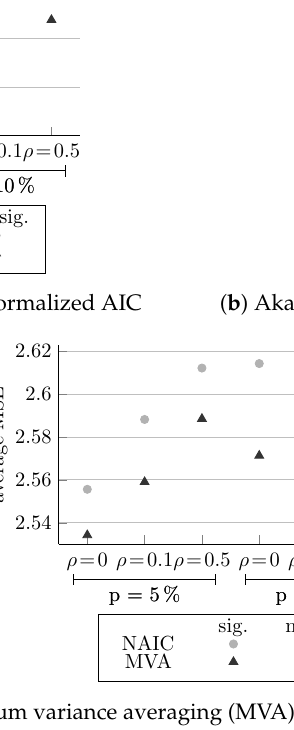
Figure 4. Comparing the MSE of the methods extending the normalized AIC and normalized AIC (NAIC), averaged over 100 simulations, and the significance of the